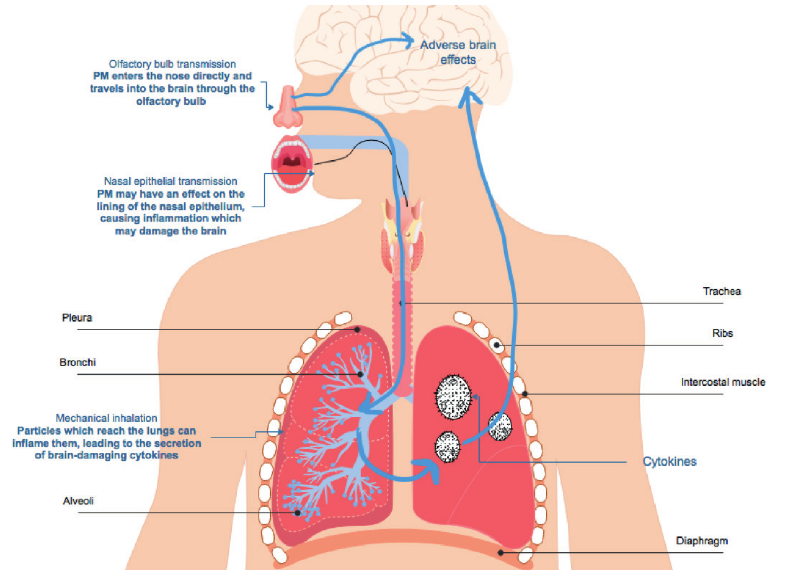
Figure 2. The possible pathways for air borne pollutants to enter the